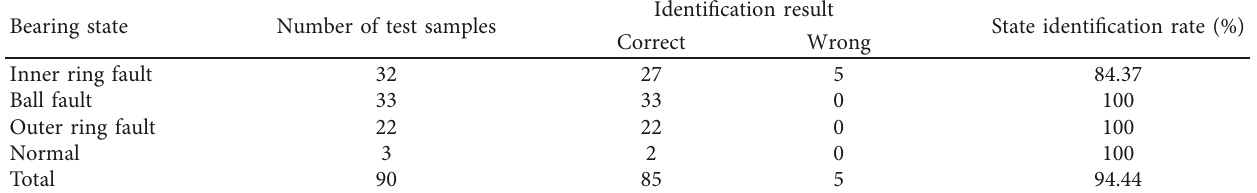
Table 11: Test set identification